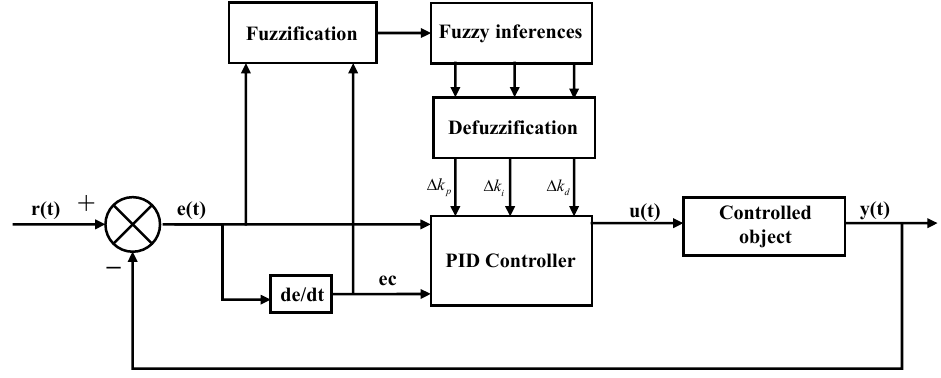
Figure 7. Principle of fuzzy–PID control system.